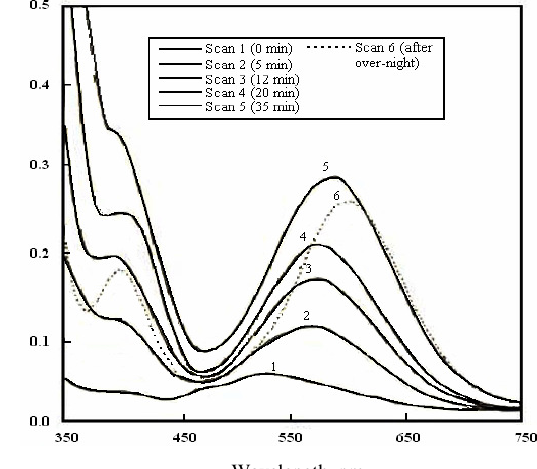
Figure 3. Spectral scan of the reaction mixture of [Co II HDTA(H pH = 4.0 ± 0.02, I = 0.1 M (CH